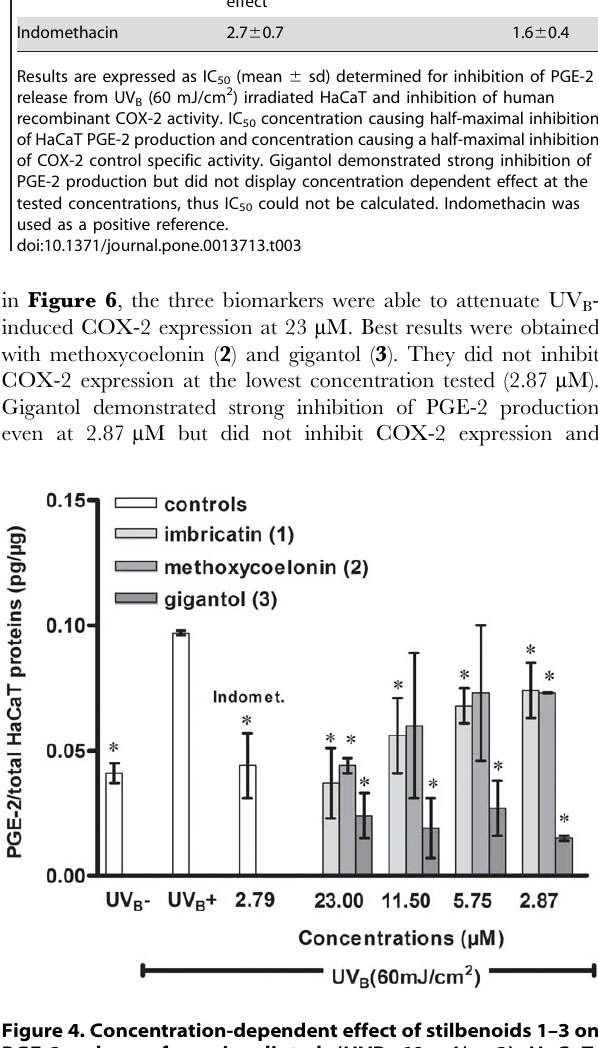
PGE-2 release from irradiated (UVB 60 mJ/cm2) HaCaT. Histogram represents the quantity of PGE-2 produced (PGE-2/ total HaCaT proteins pg/ m g) according to different treatments. Untreated irradiated (UVB + ) and non irradiated (UVB-) HaCaT were used as positive and negative controls, respectively. Indomethacin (Indomet.) at 2.79 m M represented the positive reference (54% inhibition of PGE-2 produc- tion). Inhibition percentages of PGE-2 release were calculated by comparison with the positive control: UVB + . Values represent mean 6 sd of three independent experiments. Treatment groups were compared by using one way analysis of variance ANOVA post-hoc test. Student paired t test was used to compare each stilbenoid effect to the positive control. Statistical significance (*) was set at p , 0.05. Significant differences were observed between each biomarker effect. IC50 were calculated with more points than those represented here on the graph.